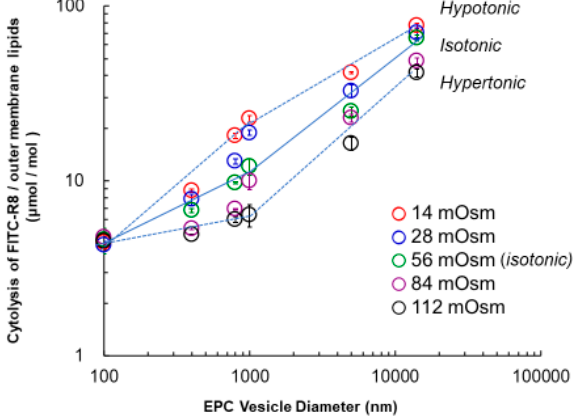
Figure 3. Effect of vesicle size with osmotic pressure change for FITC–R8 cytolysis to EPC vesicles. L/P = 1000, 37 °C, 10 min, n = 3; cytolysis amount of FITC–R8/outer membrane lipids ( μ mol/mol).